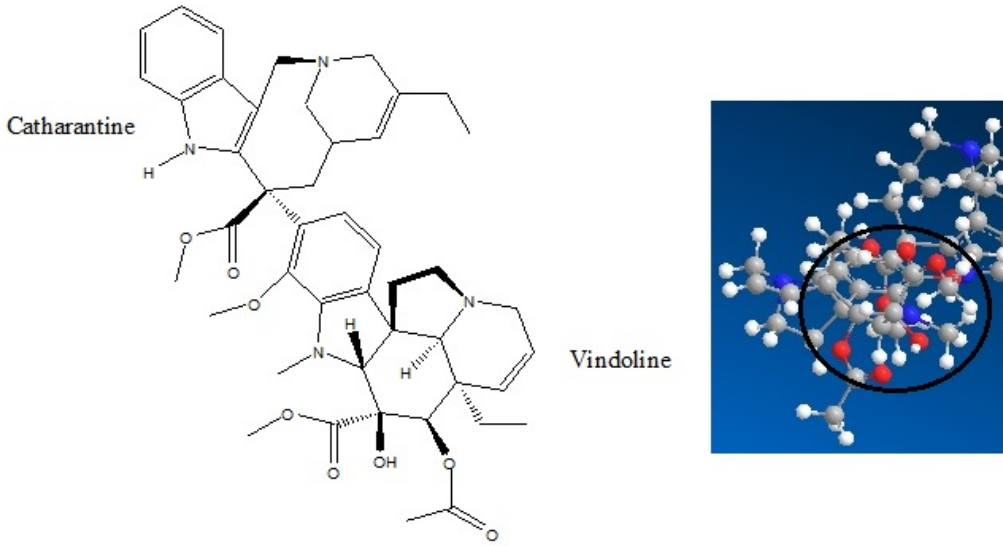
Figure 1. Structure of Vinorelbine and 3D illustration of its structure showing the localization of its functional